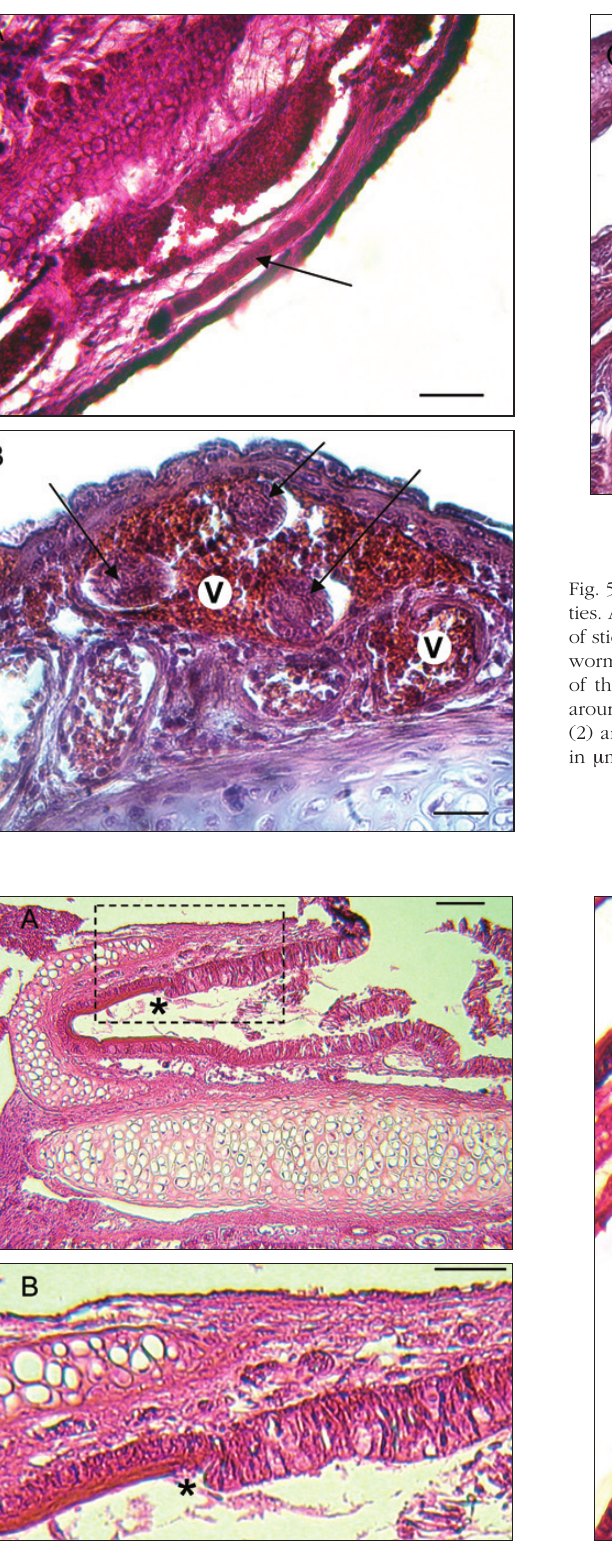
Fig. 6. – Trichosomoides nasalis in the pseudostratified epithelium. A, the two types of epithelia of the anterior concha: epithelium with mucous cells and pseudostratified epithelium without mucous cells but with keratinized upper lining. B, marked area in A enlarged to show detail of contact between the two epithelia. C, Trichosomoides nasalis female in the pseudostratified epithelium. Note the large longitudinal blood vessel below. * Marks contact between pseudostratified epithelium (on the right, with a parasite indicated by arrows) and epithelium with mucous cells. Scale bars in μ m: A, C, 100; B,